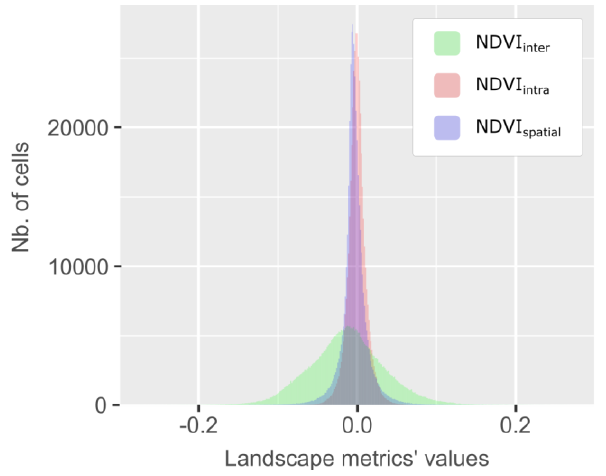
Figure 6. Histogram of the Normalized Di ff erence Vegetation Index (NDVI)-based landscape metrics’ Figure 6 . Histogram of the Normalized Difference Vegetation Index (NDVI)- based landscape metrics’ values. Total number of cells = values. Total number of cells = 438,348.